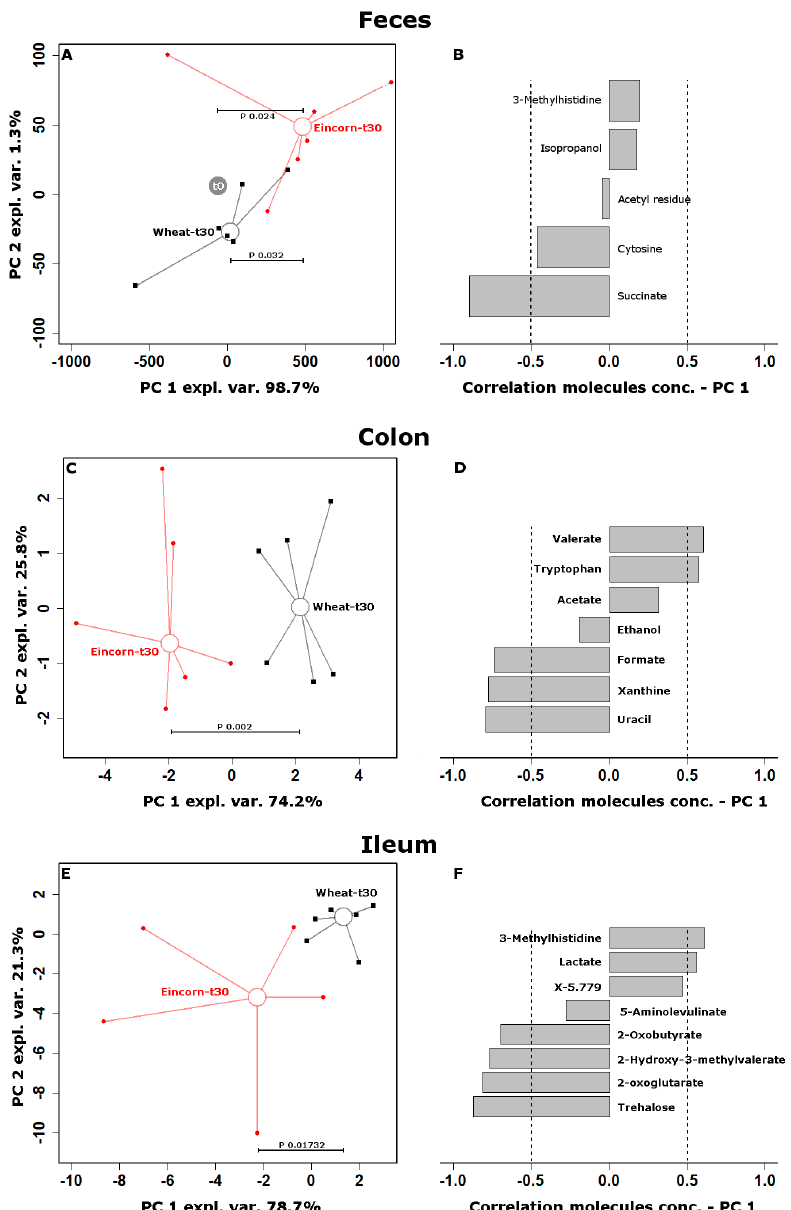
Figure 5. Metabolomics signatures along the pig intestine, associated with einkorn or wheat bread-based intervention. Robust principal component analysis (RPCA) models were calculated on the concentrations of significantly different molecules between the wheat (WB) and einkorn bread (EB) groups, as outlined in Supplementary Tables S5–S7, centered and scaled to unity variance. Panels ( A , C , E ) show the corresponding score plots, with samples from the WB group represented by black squares and samples from the EB group by red circles. The samples are connected to their median values by lines. Panels ( B , D , F ) show the corresponding correlation between molecules concentrations and their importance along PC 1, with dashed lines evidencing correlations lower than − 0.5 and higher than 0.5. In panel ( A ), the samples at t0 are superimposed because their metabolome has been subtracted to the one of each sample from the same subject to consider the paired nature of the data.